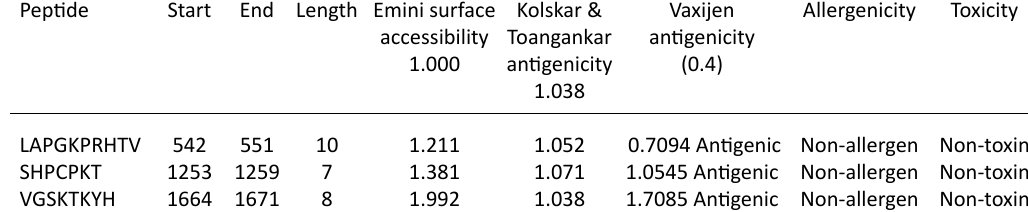
Table 1. The predicted B cell epitopes, their antigenicity, allergenicity and toxicity from the AEV polyprotein Peptide Start End Length Emini surface Kolskar &